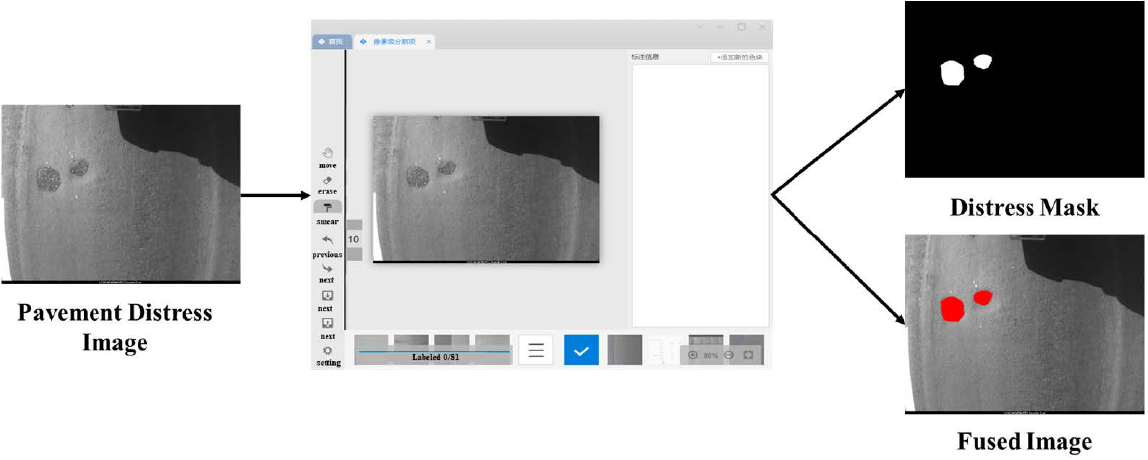
Figure 3. Pothole images labelling procedure.